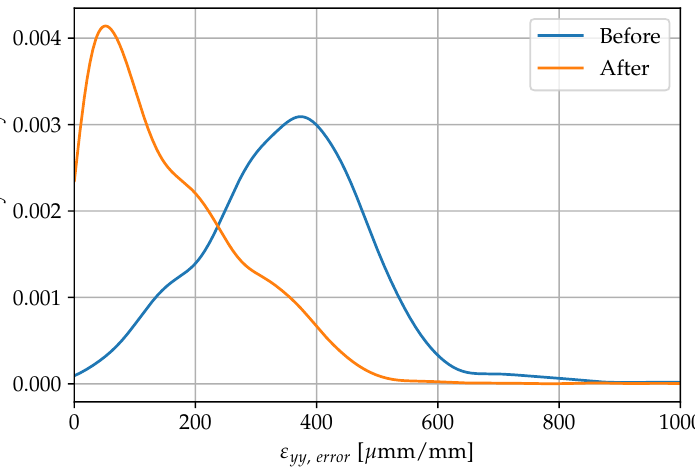
Figure 10. A histogram showing the change in the probability density of the error from the application of the error compensation method. This data is also for the 700th image of Test 1.